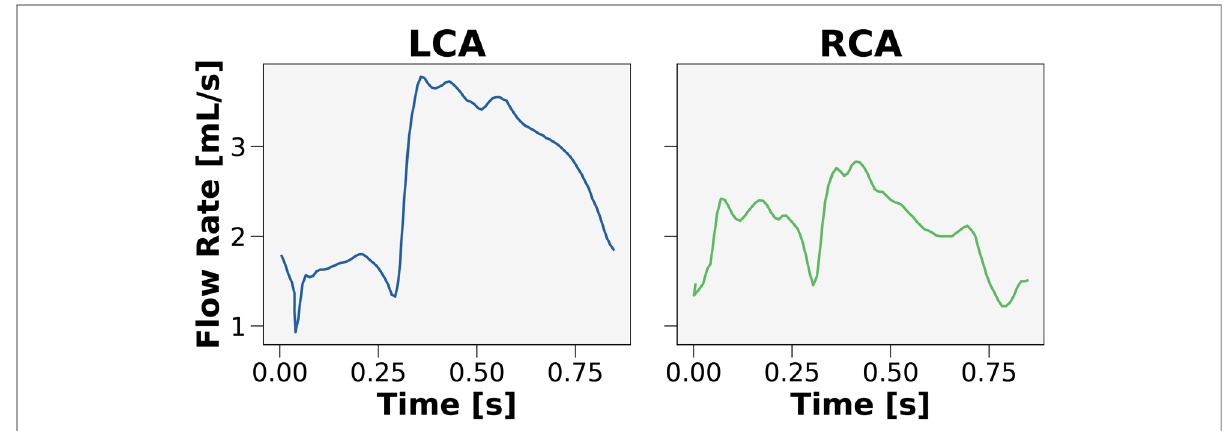
FIGURE 2 Canonical waveforms for the left and right coronary circulation. Hyperemic pulsatile fl ow rate waveforms were used as inputs to the streamlined model for the left (LCA) and right (RCA) coronary arteries. The waveforms were generalized over the 50 patients in the